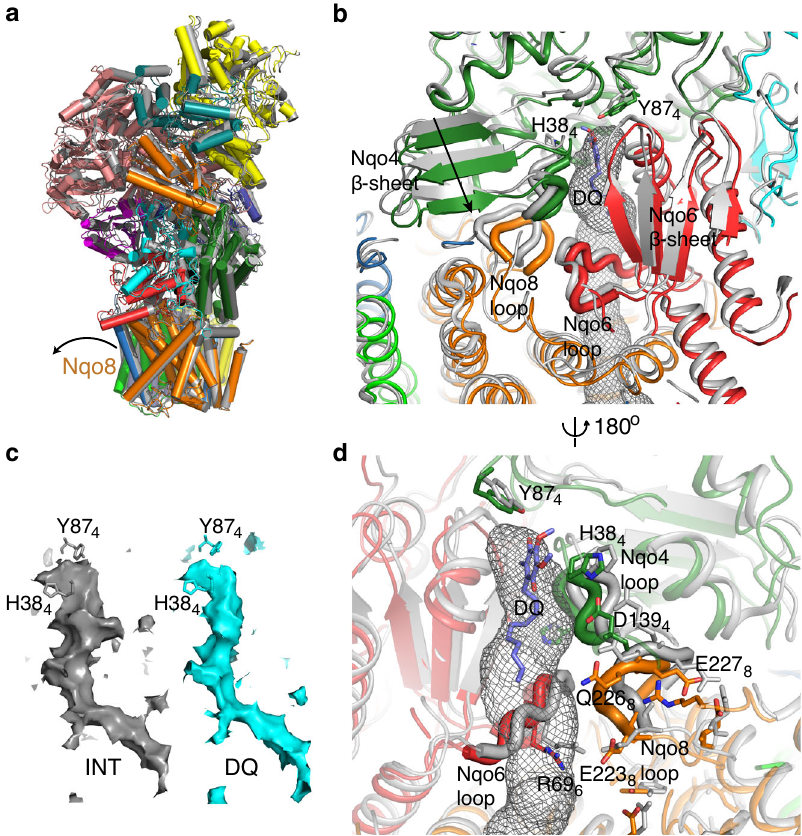
Fig. 5 Conformational changes observed after binding of DQ. a Overlay of CXI INT (grey) with CXI DQ structure (coloured subunits, Nqo4 in dark green, Nqo6 in red and Nqo8 in orange). The structures were aligned by the MDs. Note that upon DQ binding Nqo8 tilts in the direction of the arrow, with tilt developing further in the PA. b , d Zoom-in into the Q-site, the same alignment as in a , with CXI INT in grey and CXI DQ coloured. The Q cavity is indicated with a grey mesh (calculated in MOLE) and bound DQ is in violet. The movement of the key Nqo4 β -sheet is indicated by an arrow. Key loops fl anking the Q-site (Nqo4 32 – 39, Nqo6 66 – 75 and Nqo8 223 – 229 residues) are shown as thick tubes, with key residues from these loops indicated. c The Q cavity shown as solvent-accessible surface (calculated in Pymol with 1.4 Å probe). Note that the cavity gets narrower around H38 4 residue in the CXI DQ structure (cyan) as compared with CXI INT